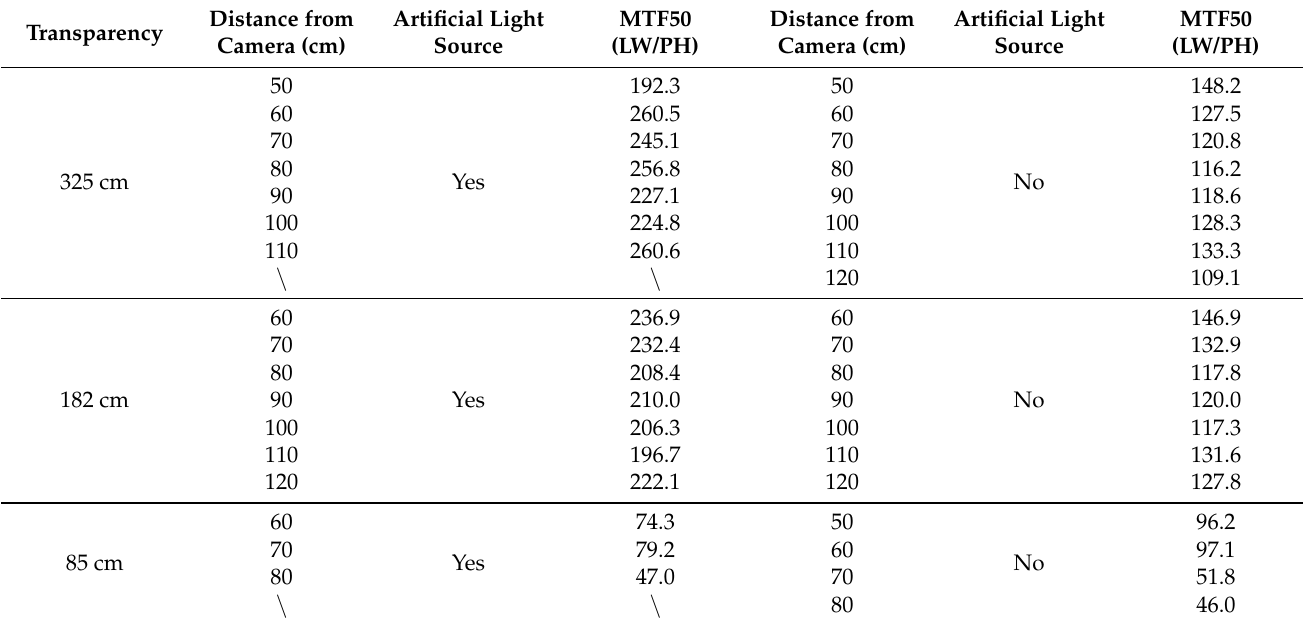
Table 3. Analysis results of SFR plus module on SFR board.